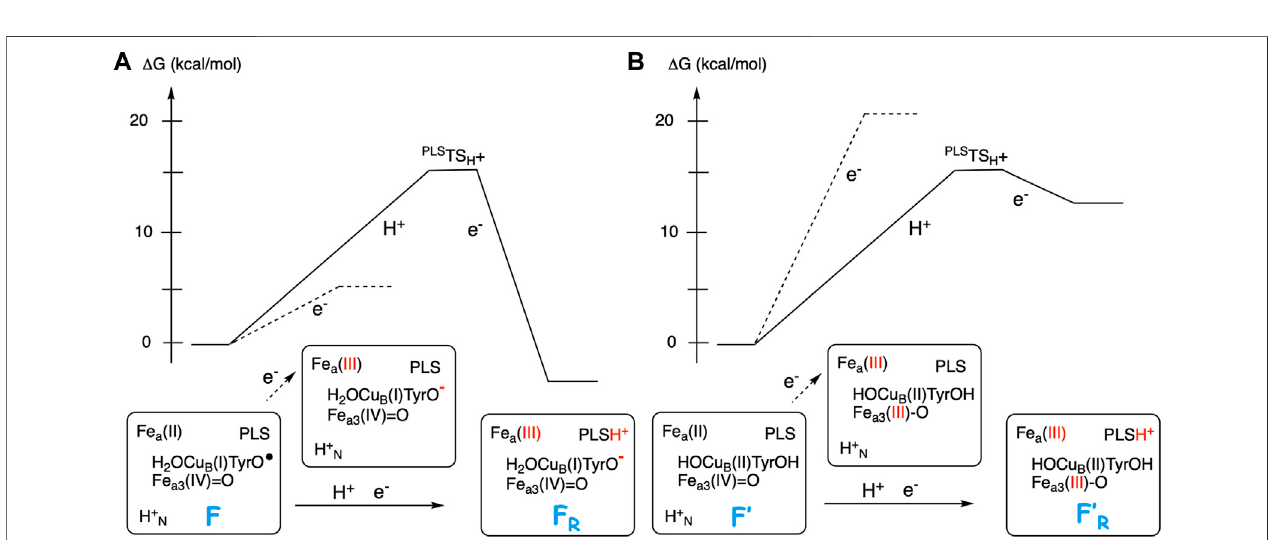
FIGURE5| Scetchofenergypro fi lesforcoupledelectrontransferfromheme a totheBNCandprotontransferfromtheN-sidetoPLS(fullcurves).Thedottedlines correspondtoonlyelectron transferfromheme a totheBNC. (A) Forthe F state,withahighEA,thecoupledreactionisexergonic. (B) Forthe F 9 state,withalowEA,the coupled reaction is